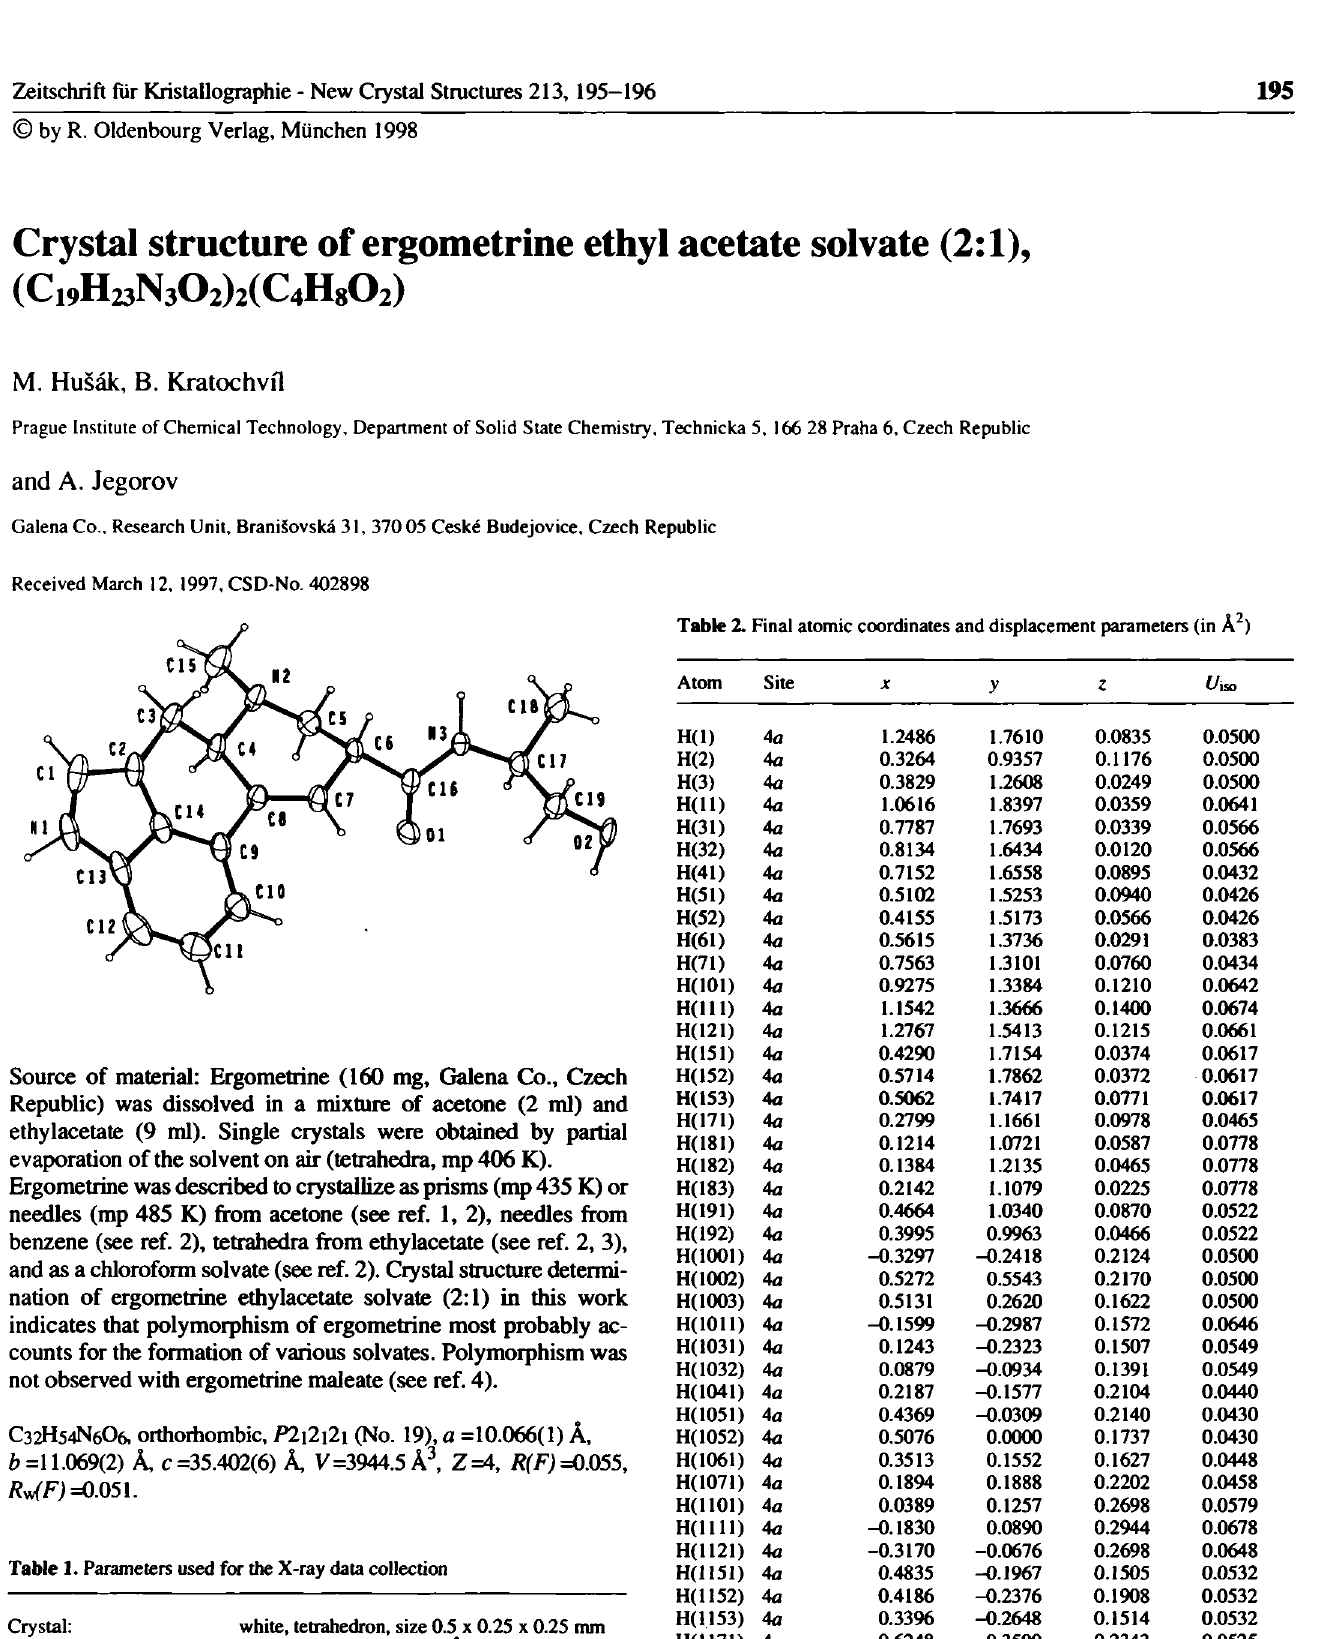
Table 1. Parameters used for the X-ray data collection Crystal: